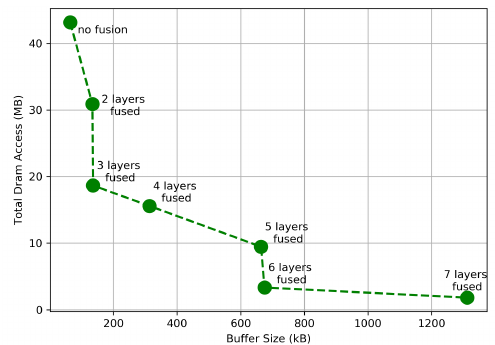
Figure 12. Minimum storage to fuse VGG16 layers.